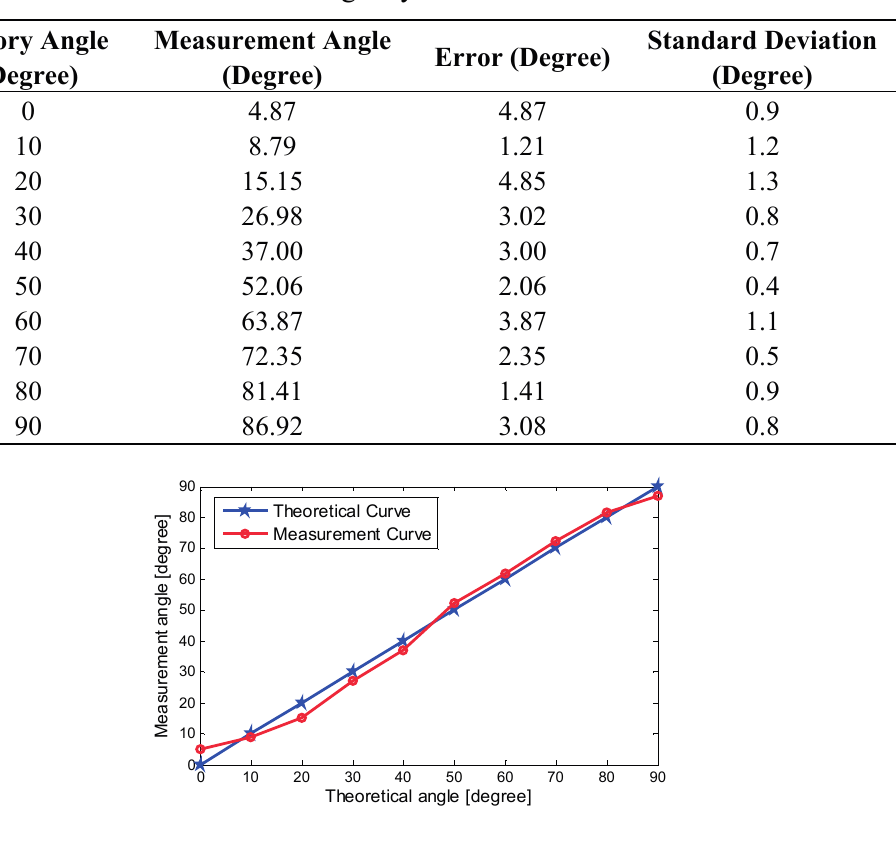
Table 1. Measurement angle by MEMS acoustic vector sensor.